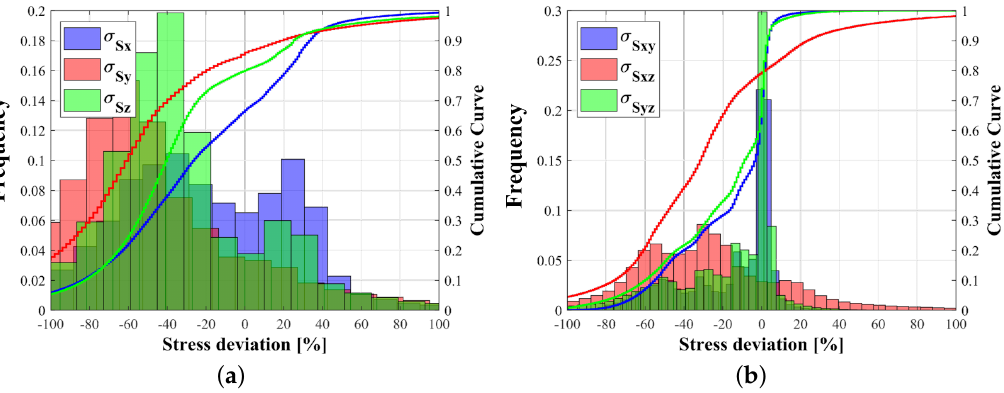
Figure 25. Statistical distributions of the stress deviations and cumulative curves in the SPs for normal ( a ) and shear ( b ) components.